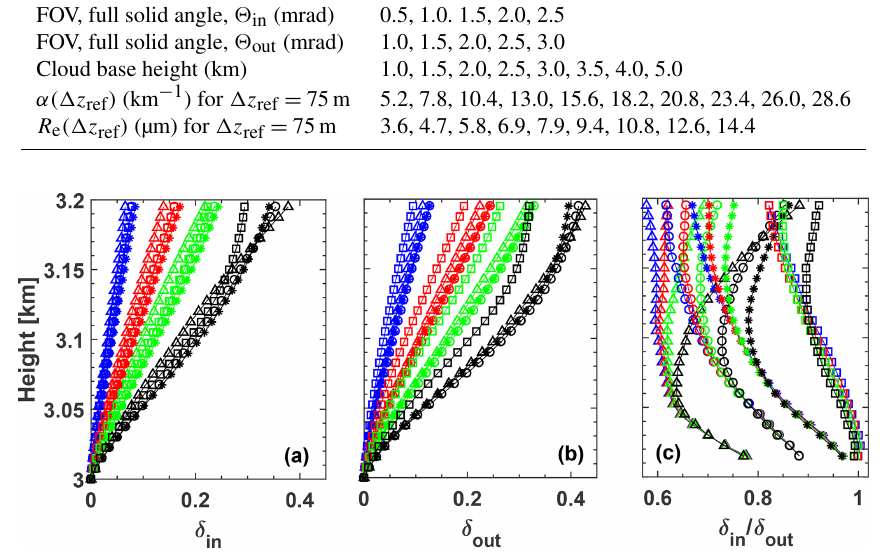
Figure 5. Simulated depolarization ratio profiles for (a) FOV in of 1mrad, (b) FOV out of 2mrad, and (c) profiles of the ratio δ in (z)/δ out (z) . α(z ref ) values are 5.2km − 1 (blue), 10.4km − 1 (red), 15.6km − 1 (green), and 26.0km − 1 (black) (see Table 1, z ref = 75m above the cloud base at z bot = 3km). Different symbols indicate different simulated R e (z ref ) values (3.6µm (triangle), 5.8µm (circle), 7.9µm (star), and 14.4µm (square)). A clear dependence of R e (z ref ) on δ in (z)/δ out (z) is visible up to about 100m above the cloud